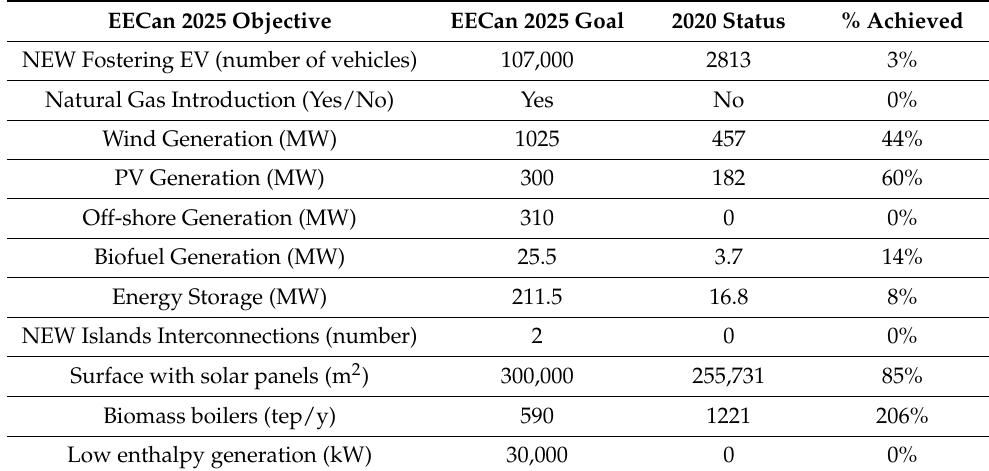
Table 2. Comparative: Objectives Set by EECAN 2025 and 2020 situation. EECan 2025 Objective EECan 2025